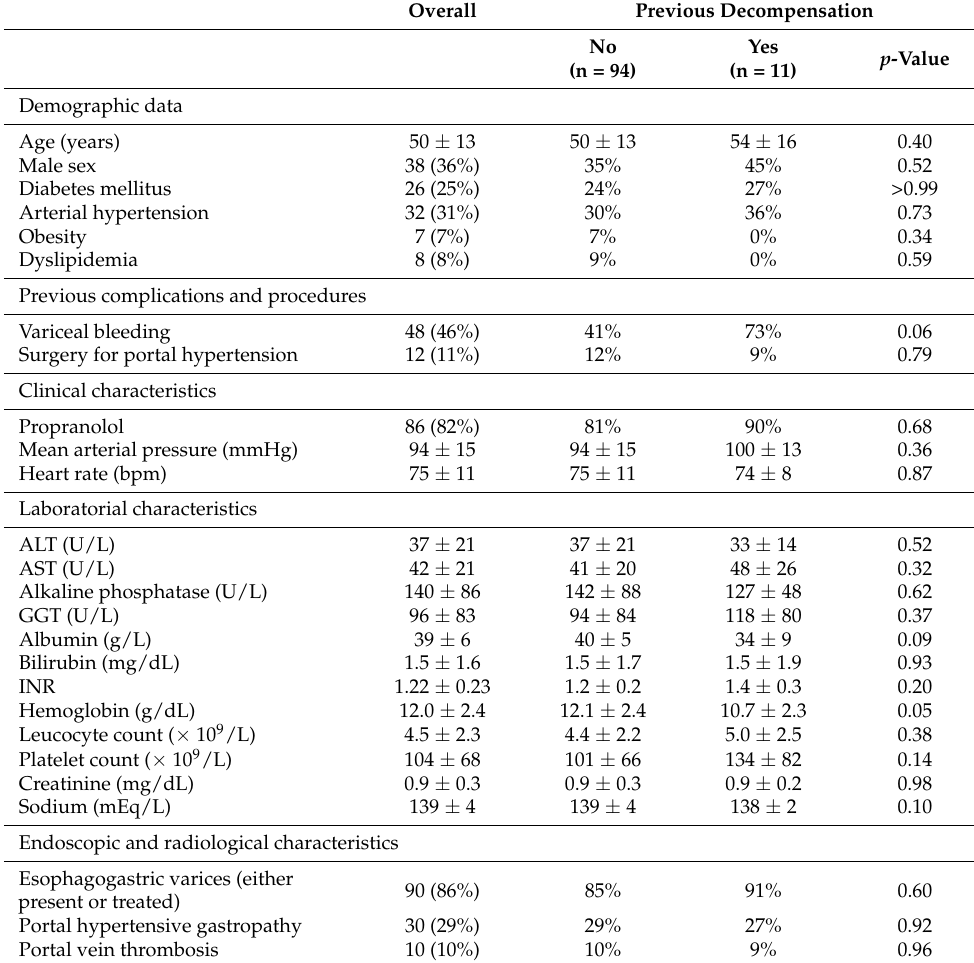
Table 1. Baseline characteristics of the study group, stratified by the presence of decompensations prior to the beginning of